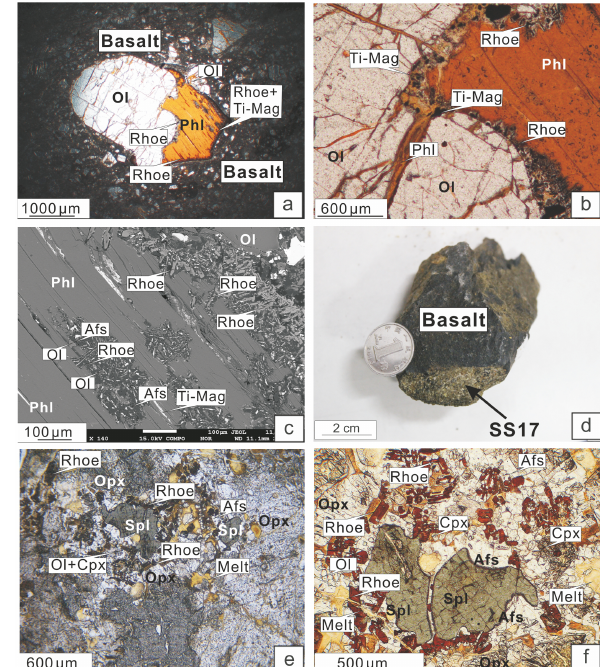
Figure 2. Microphotographs of rhönite-bearing samples CL01 (a– c) and CL04 (d–f) from Fangshan. (a) Corundum megacryst in basalt with fine-grained reaction rim. (b) Same as (a) but in back- scattered electron (BSE) mode. Note that an inner rim of spinel is located around corundum, surrounded by a rim of Ti-bearing mag- netite (white) and a coarse-grained outermost rim of rhönite + al- kali feldspar + clinopyroxene. (c) Pocket of basalt between corun- dum megacrysts with reaction rim as in (b) . (d) Thin-section im- age of a spinel megacryst and mantle xenoliths in basalt. (e) Spinel megacryst with rhönite-bearing reaction rim. (f) Spinel with reac- tion rim of rhönite + Ti-bearing magnetite. (a, d, e) Plane-polarized light (PPL); (b, c, f) BSE.